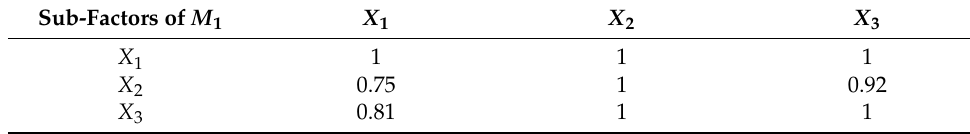
Table 8. Judgment matrix of the parent factor layer to the target layer M 1 .